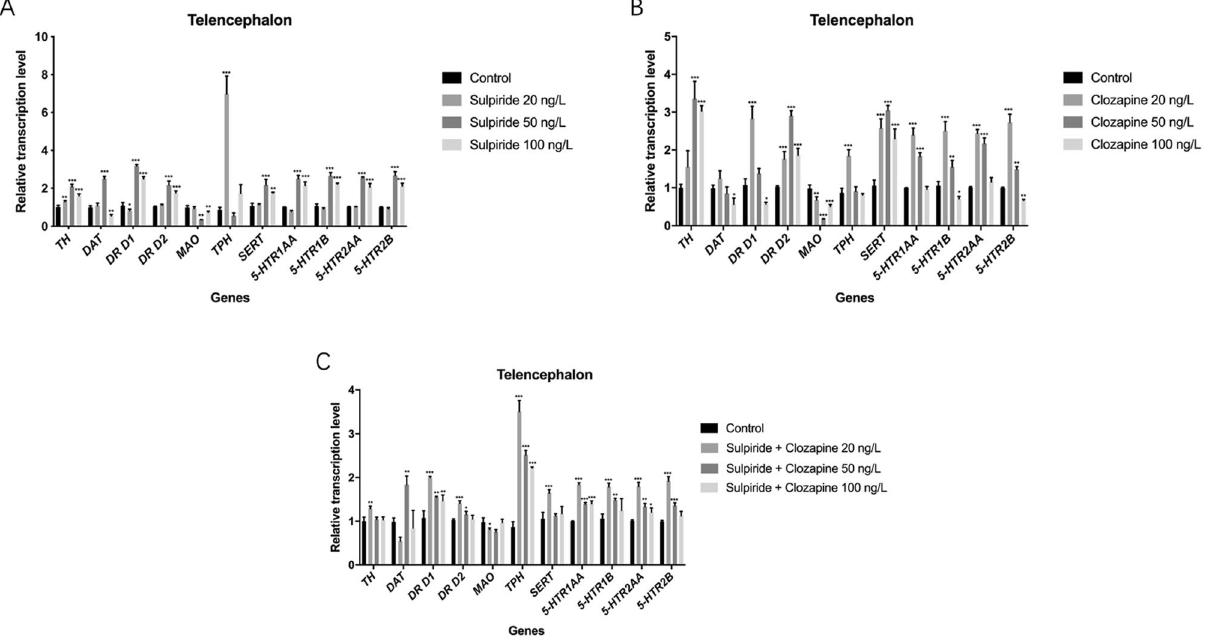
Figure 1. Changes in the mRNA levels of functional molecules involved in DAergic and 5-HTergic systems in zebrafish telencephalon induced by sulpiride and clozapine. Note: ( A ) Sulpiride, ( B ) Clozapine, ( C ) Mixture of sulpiride and clozapine. Data are presented as means ± SE (n = 10). p < 0.05 was considered statistically significant. * p < 0.05, ** p < 0.01, *** p <